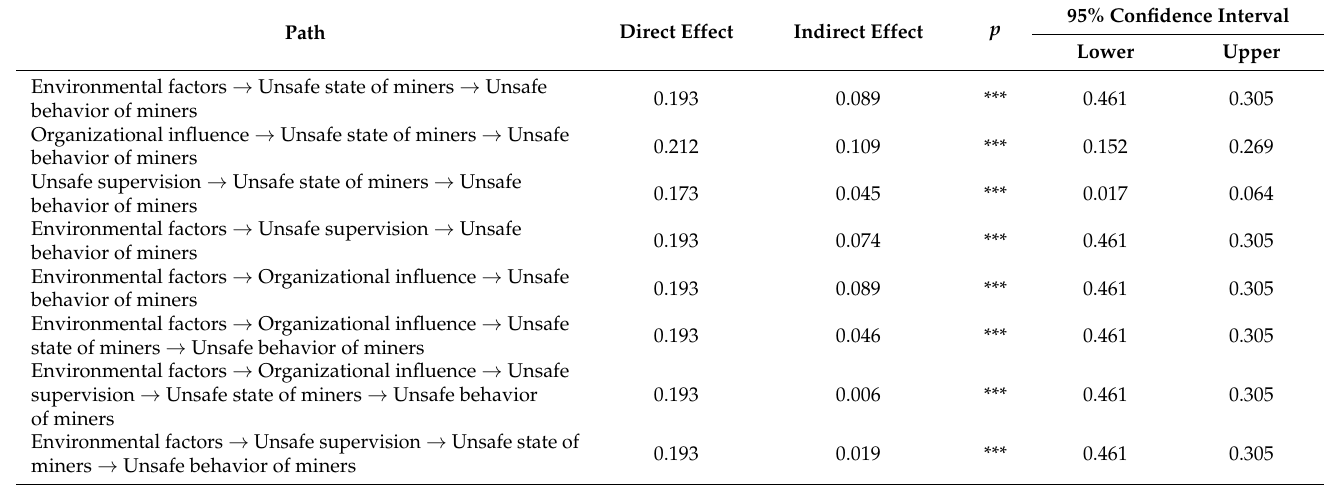
Table 7. Mediating effect test